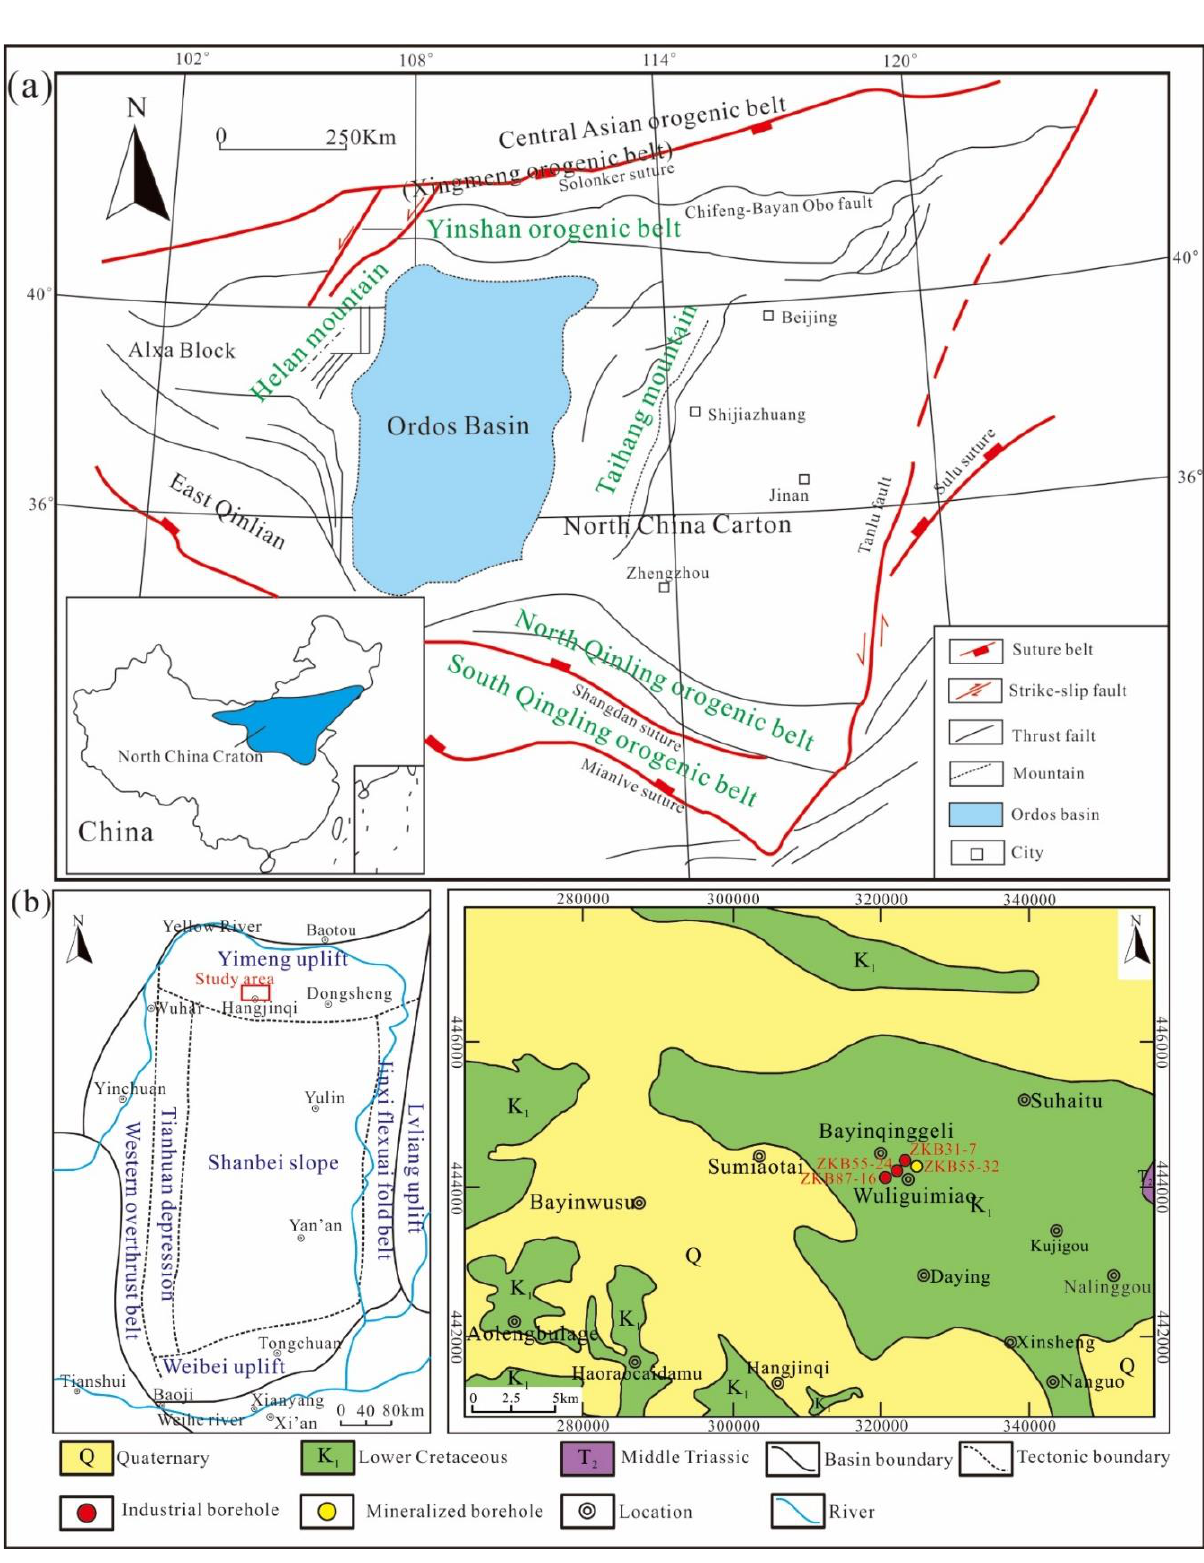
Figure 1. Map of the research area: ( a ) Simplified geological map of North-Central China [28]; ( b ) the division of tectonic units in Ordos Basin and Regional geological map of research